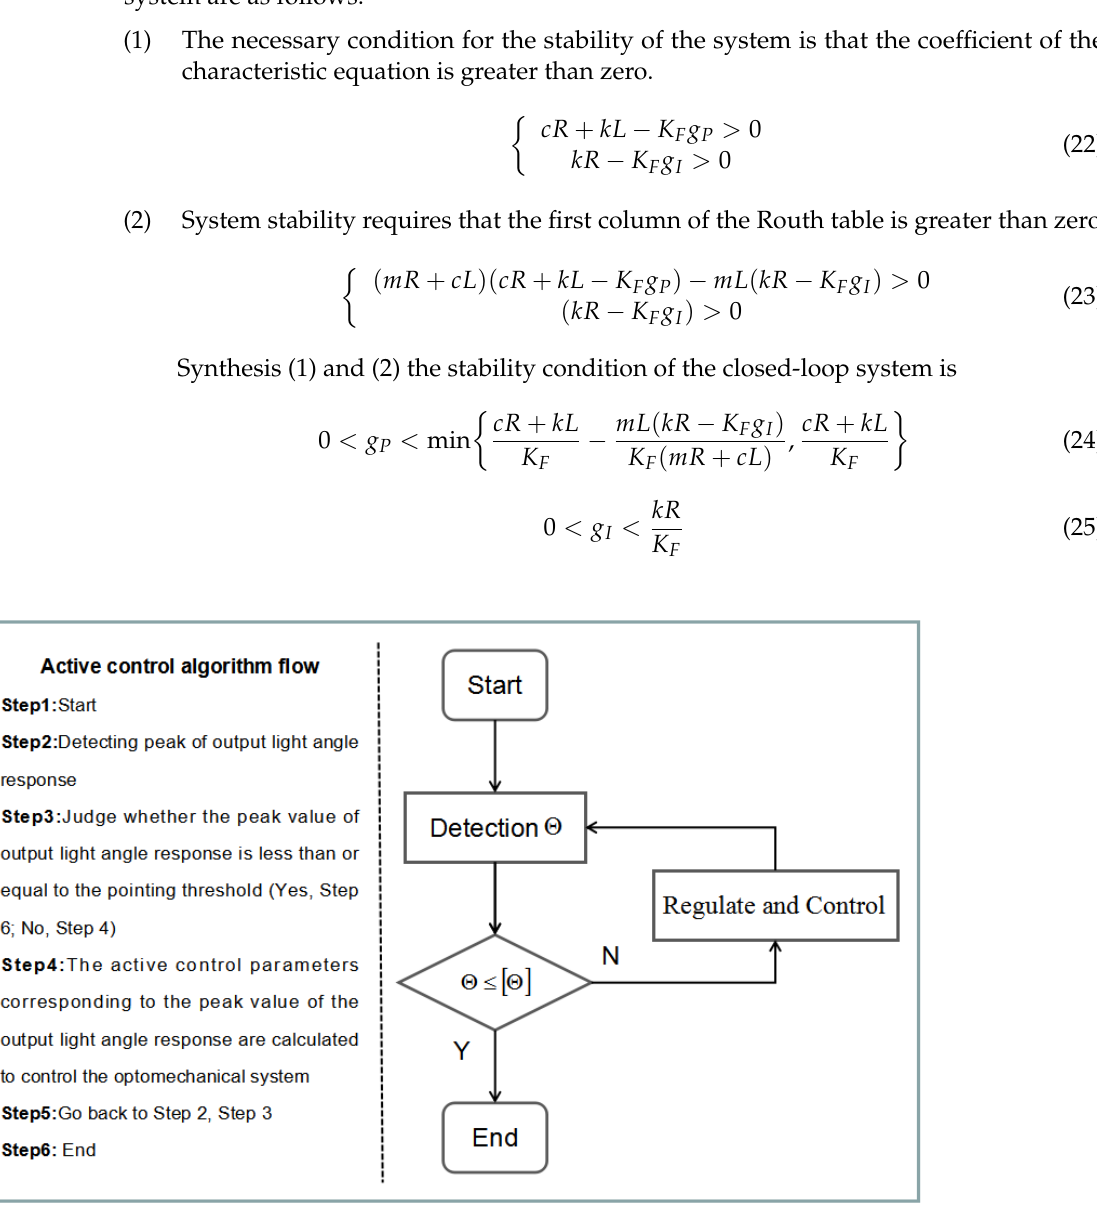
Figure 13. Algorithm flow of the spatial filter Optomechanical coupling active control system.